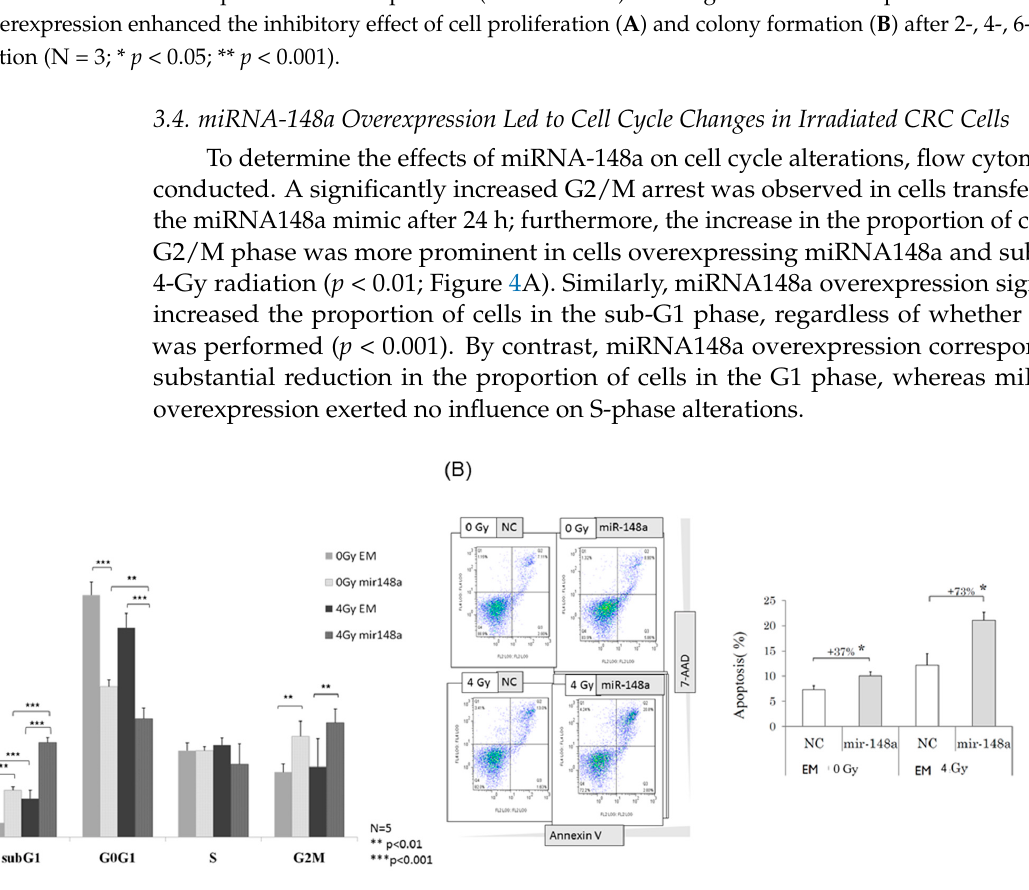
Figure 4. miRNA ‐ 148a modulated the cell cycle and promoted apoptosis in HCT116 and HT29 cells after irradiation. After synchronization with serum starvation for 24 h, cells were irradiated with 0 or 4 Gy. Flow cytometry performed after 3 days of incubation indicated that the combination of miR ‐ 148a overexpression and irradiation resulted in increased cells in the sub ‐ G1 phase, as well as G2/M arrest ( A ) and an increase in the proportion of apoptotic cells ( B ) (N = 3; * p < 0.05; ** p < 0.01).